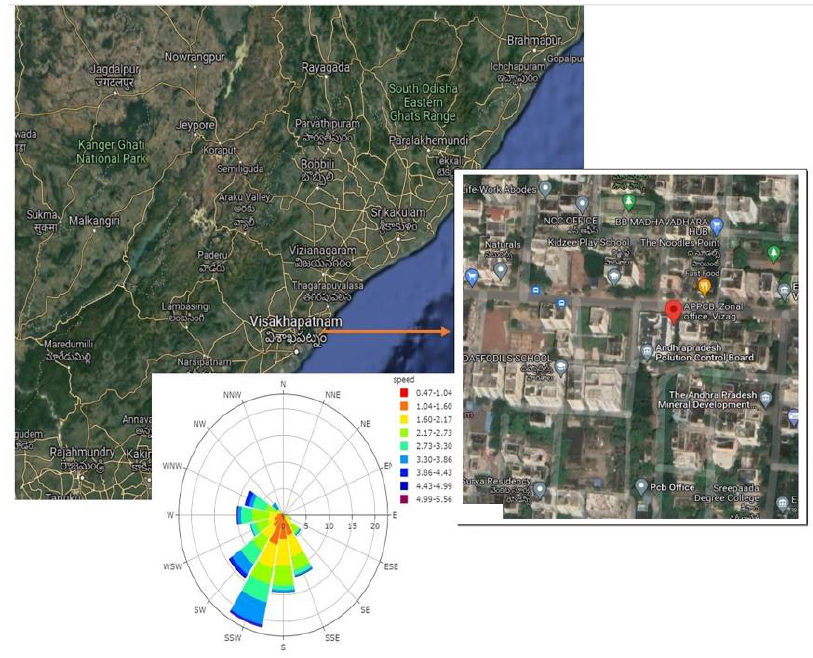
Figure 2. Location of port city Visakhapatnam (courtesy: google maps), and wind rose diagram (2018 – 2019) of study area.